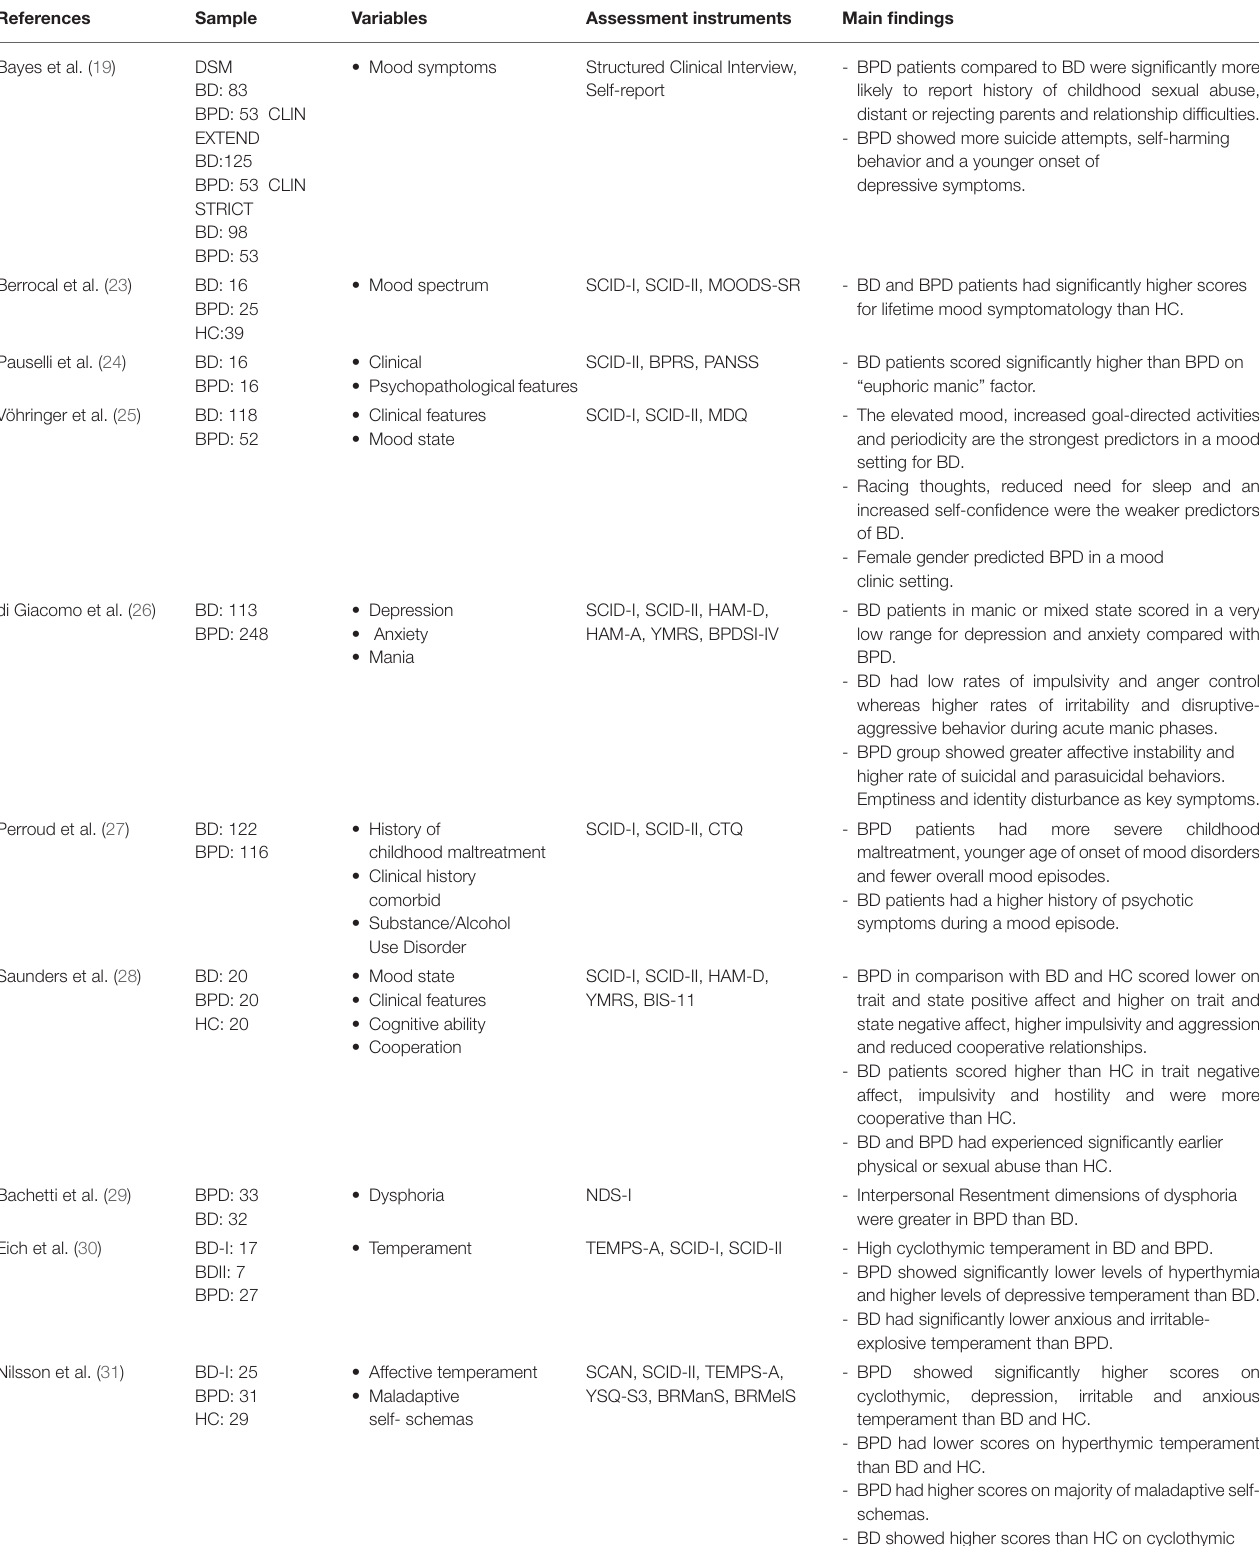
TABLE 1 | Clinical features between bipolar disorder and borderline personality disorder. Sample Variables